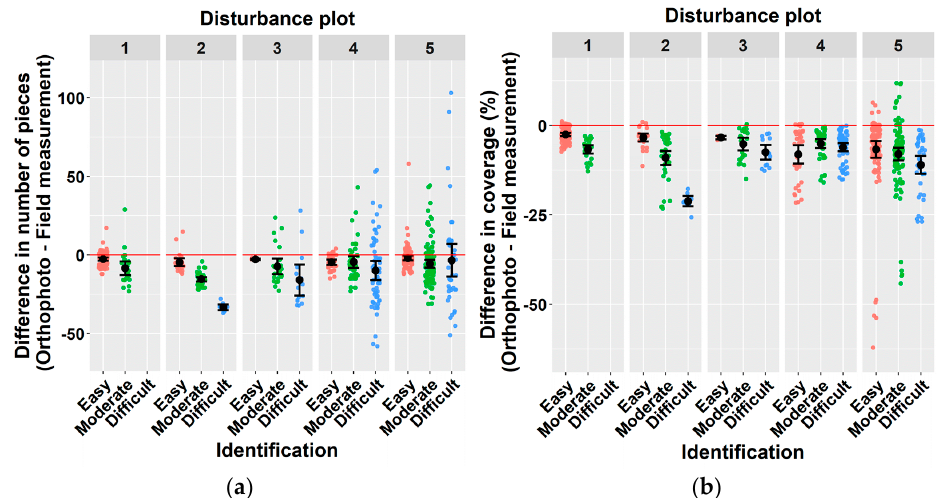
Figure 4. Impact of the difficulty of deadwood identification on the accuracy of number of deadwood pieces ( a ) and deadwood coverage ( b ) estimated from orthophoto images. Identification difficulty was specified based on the number of deadwood pieces on the plot (easy = 0–15 pcs, moderate = 16–35 pcs, difficult= more than 35 pcs of deadwood).